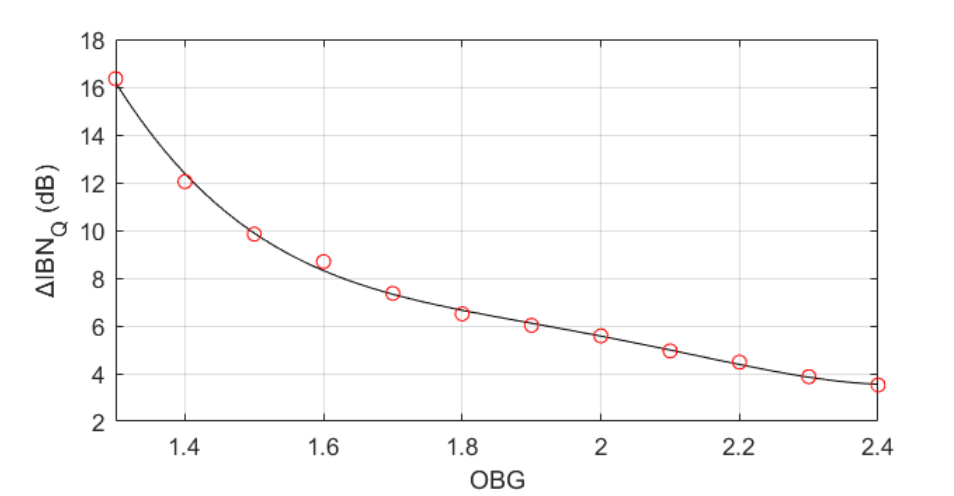
Figure 20. Dependence of ∆ IBN Q on NTF OBG. Red circles show simulation results; a black line shows the estimation using (25).